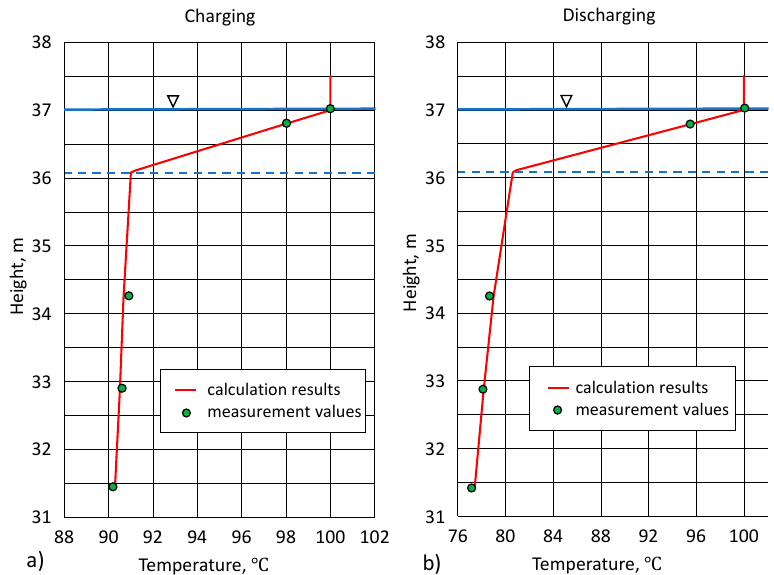
Figure 10. Comparison of calculation results with measurement data for heat transfer from the steam cushion space to the hot water stored in the upper part of the TES tank for Białystok CHP plant: ( a ) charging process of the TES and ( b ) discharging process of the TES.